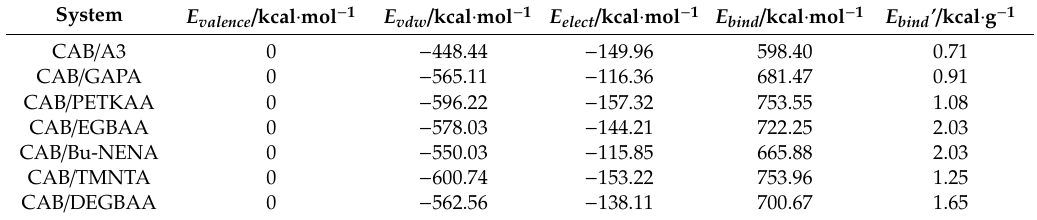
Table 2. The binding energies ( E bind ) and per unit mass binding energies ( E bind ’ ) between CAB and di ff erent